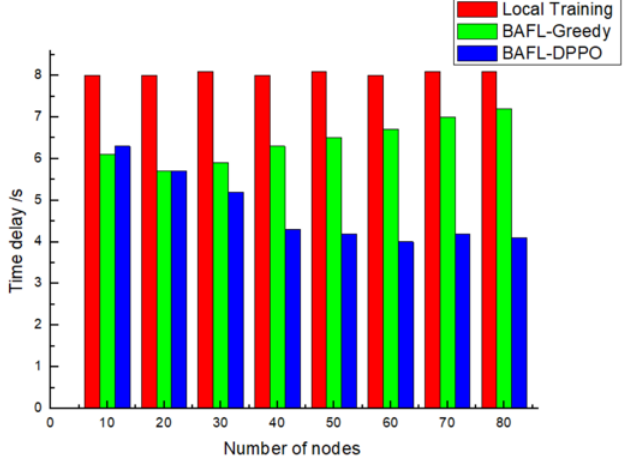
Figure 8. Comparison of losses (30% of malicious device nodes).